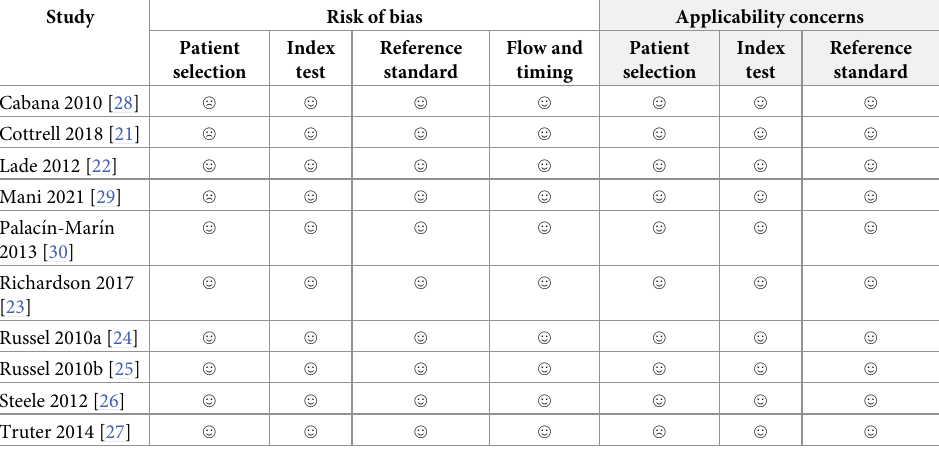
Table 3. QUADAS-2 risk of bias assessment of included studies reporting validity.